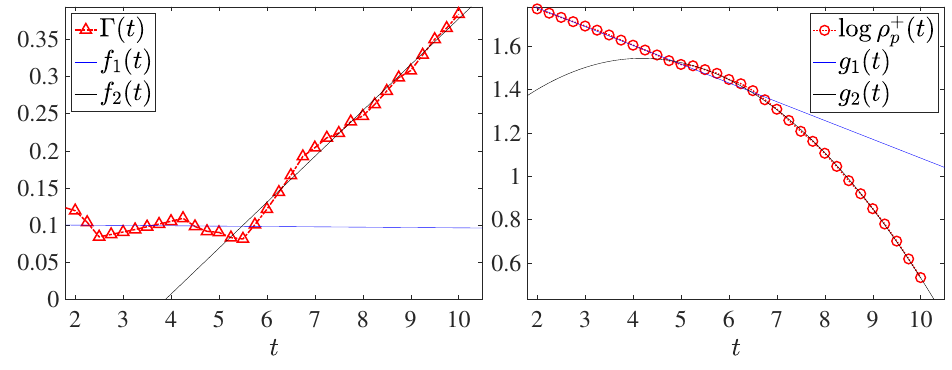
Figure 3 . Left: the function Γ( t ) at the maximum of the subsidiary peak, displaying nearly constant behaviour for intermediate times and linear behaviour for later times. Right: the function log( ρ which is related to Γ( t ) through (3.10), displaying the expected linear decay for intermediate times and quadratic decay for later times. The functions f mutually related as expected from (3.10). In both pictures the simulation parameters are σ = 10 , log(2 T ) = 7 and T = 0 m a